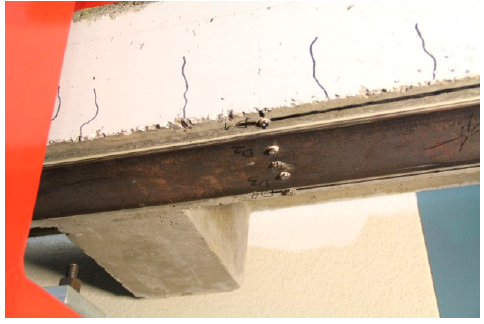
Figure 17. Bottom side of the beam in the year 2015. Surface corrosion is visible on the steel plate.